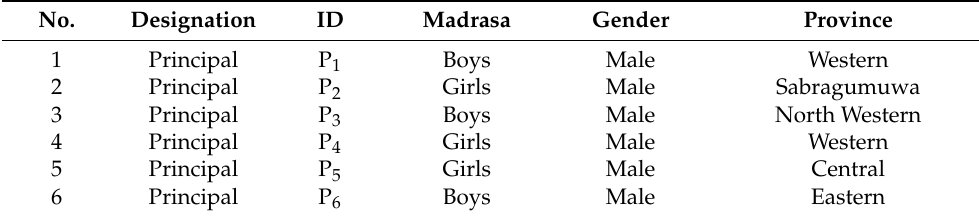
Table 1. Participants in qualitative data